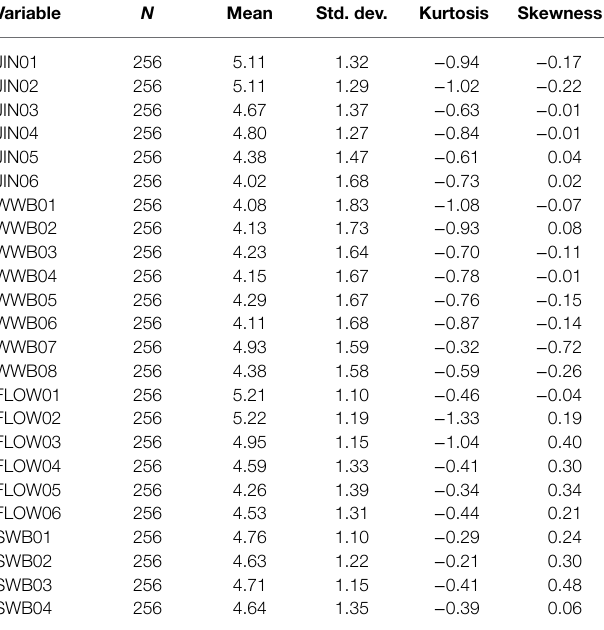
TABLE 4 | Descriptive statistics